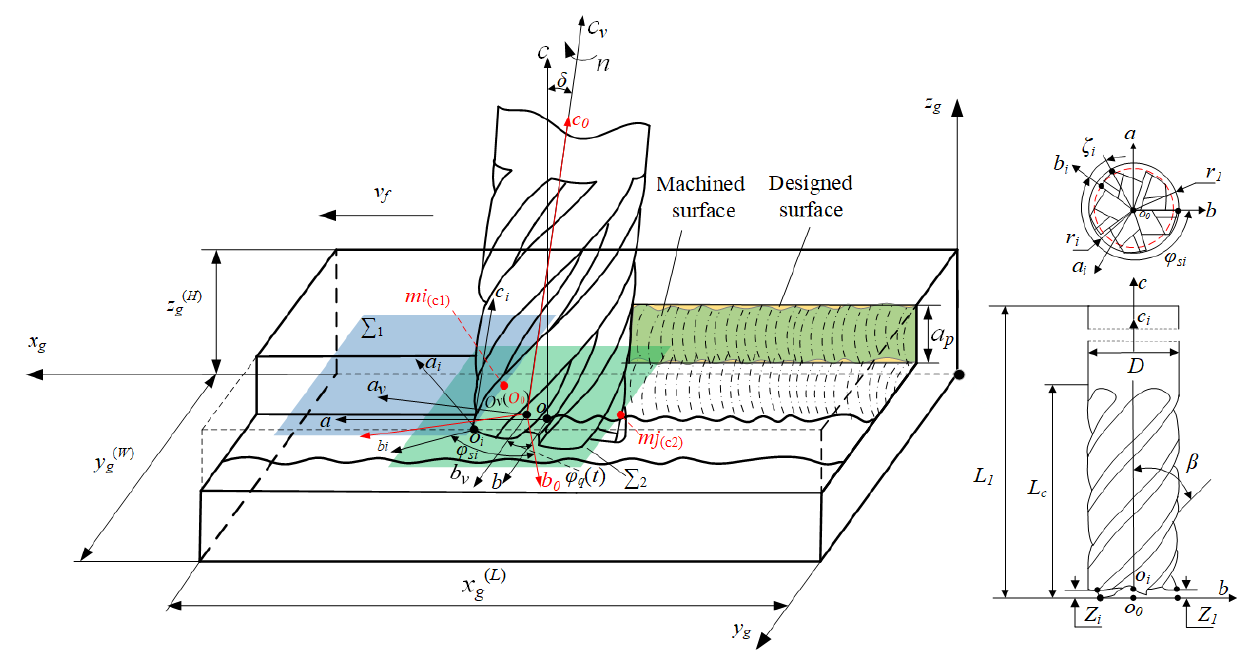
Figure 1. The instantaneous cutting attitude of a high-efficiency milling cutter. Table 1. Meaning of milling cutter structure and cutting state parameters.